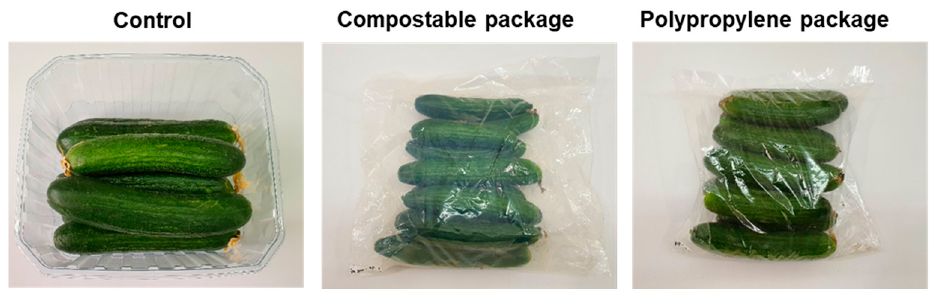
Figure 1. Visual appearance of control, compostable and polypropylene packages of cucumber